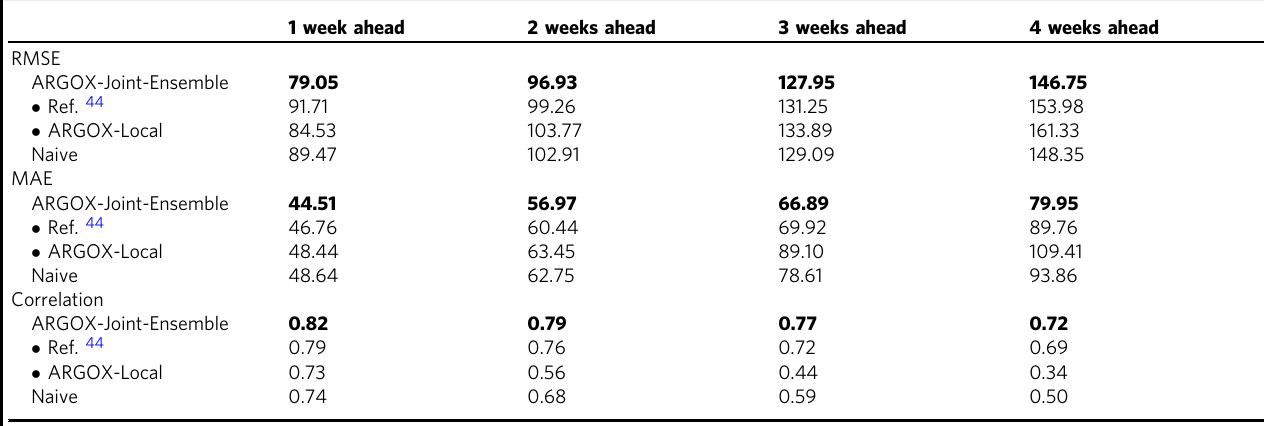
Table 1 Comparison of different methods for state-level COVID-19 1 – 4 weeks ahead deaths predictions in 51 U.S.